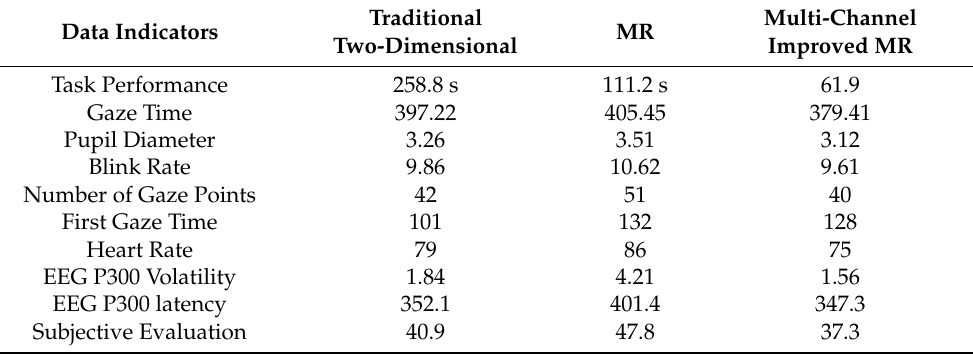
Table 11. Subjective and objective